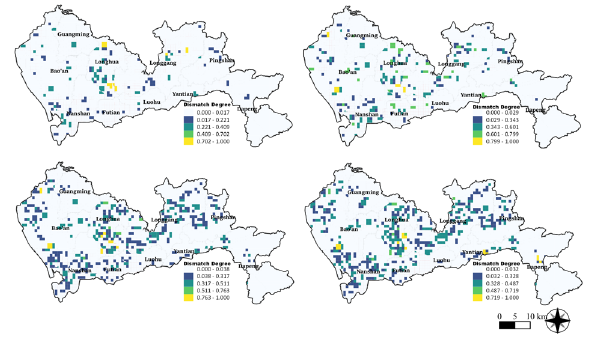
Figure 8. M ismatch degree of supply and demand of residents' living materials under different extents of simulation Neighborhood’s No.